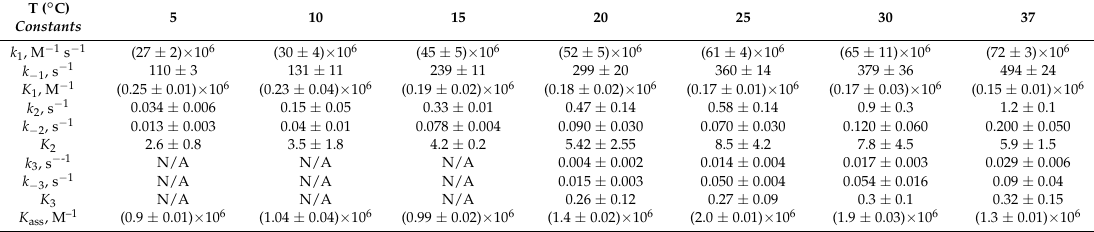
Table 2. Rate and equilibrium constants corresponding to the interaction of Endo III with